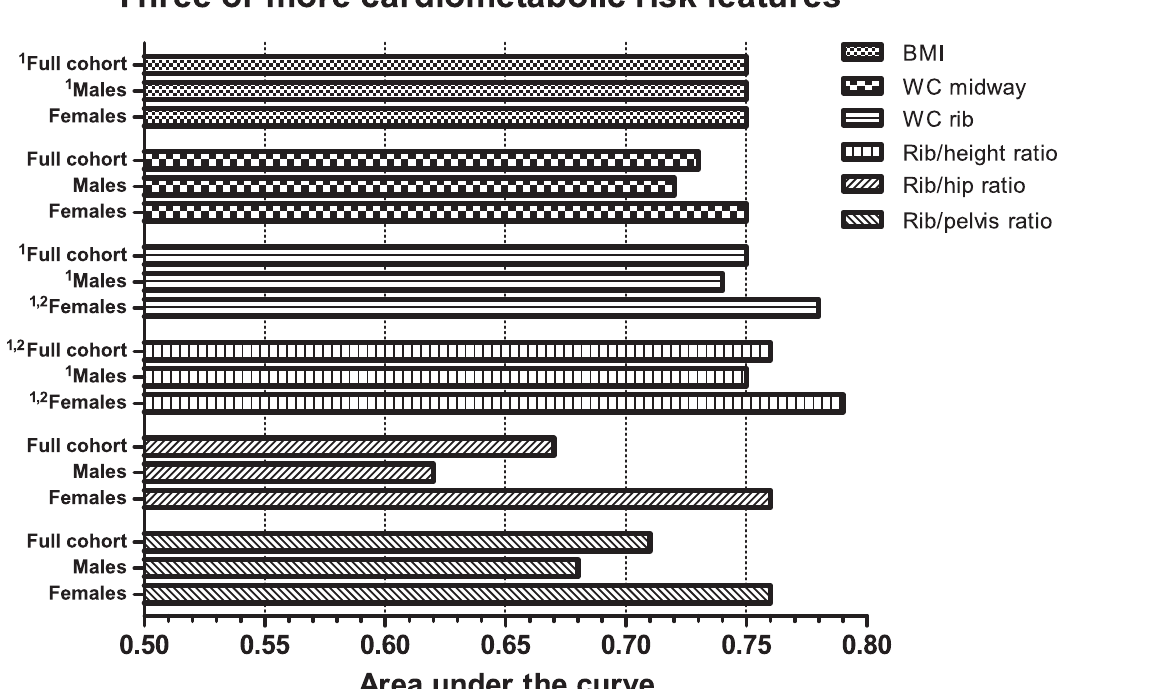
Fig 3. Adjusted area under the receiver operating characteristic curve values for selected obesity measures to discriminate subjects with three or more cardiometabolic risk features. Bars represent AUC values. All models exclude subjects with type 2 diabetes. Statistical differences in the AUC values are shown in superscript Arabic numbers as: 1 P < 0.05 compared to WC midway; 2 P < 0.05 compared to